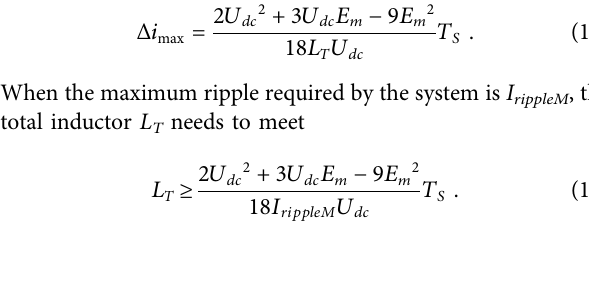
Frontiers in Energy Research |